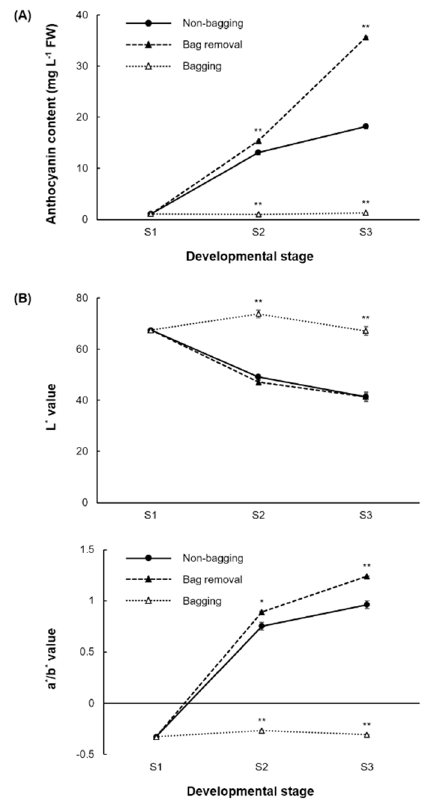
Figure 2. Measurements of ( A ) anthocyanin accumulation and ( B ) color parameters ( L * and a */ b *) in the skin of ‘Fuji’ apples cultivated under different bagging treatments: no bagging (control; labeled as “non-bagging”), bagging followed by bag removal (labeled as “bag removal”), and bagging with no bag removal (labeled as “bagging”). Apples were harvested at three time points: before paper- bagging (S1, DAFB 97) and then 1 and 4 weeks after bag removal (S2, DAFB 169 and S3, DAFB 191). Bars represent the standard error of triplicate samples. * and ** indicate significance levels of p < 0.05 and p < 0.01, respectively. DAFB, days after full bloom.